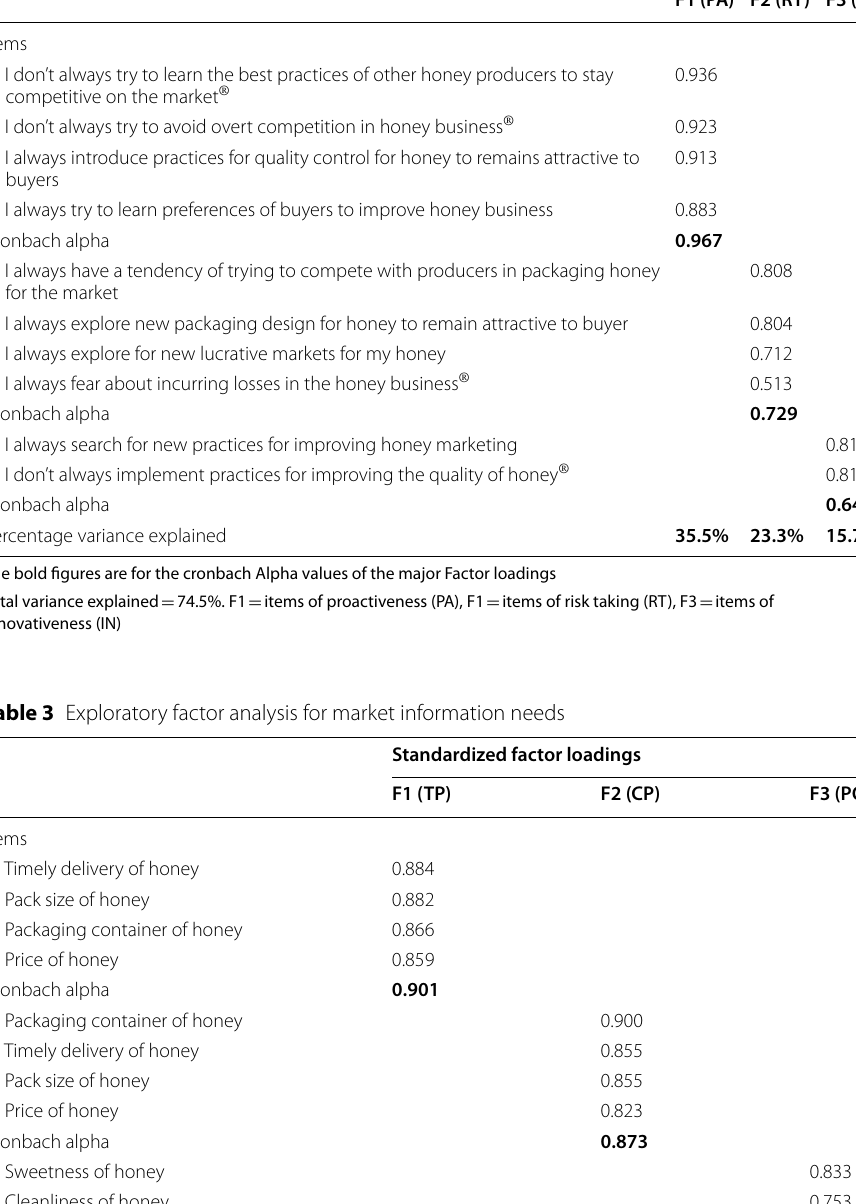
Table 2 Exploratory factor analysis for entrepreneurial orientation